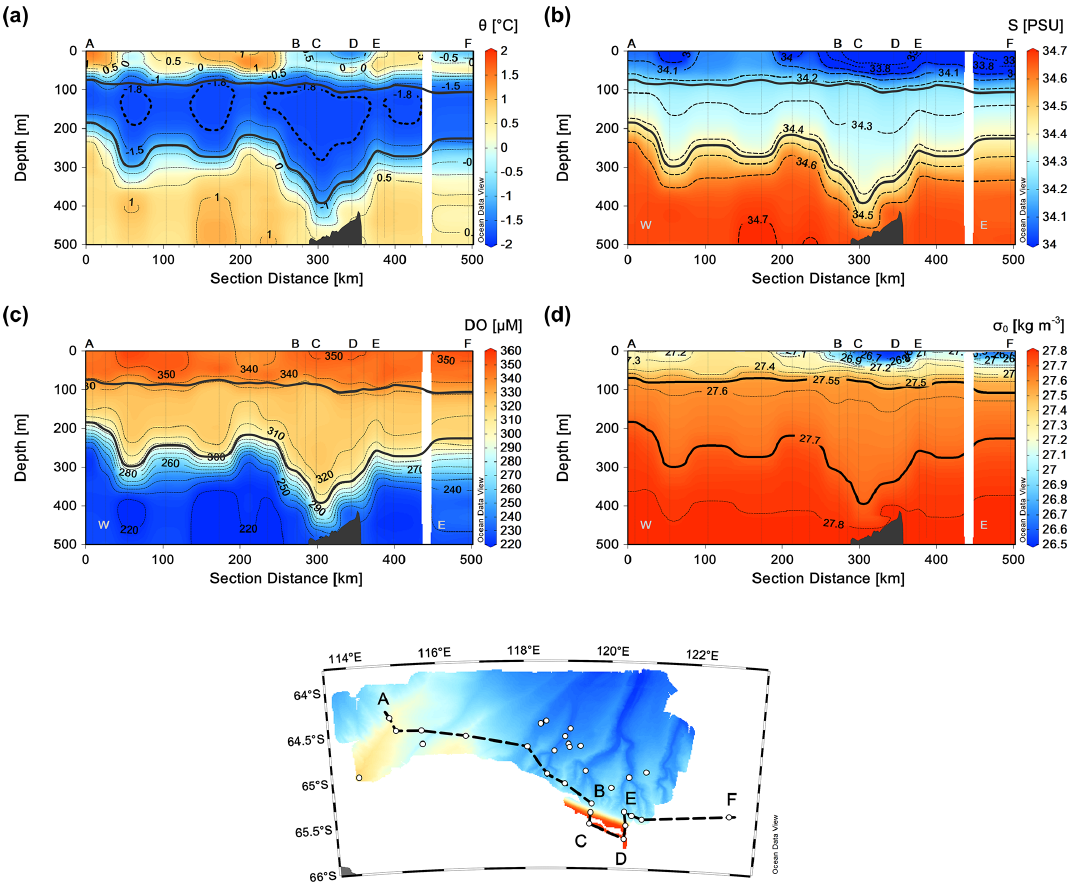
Figure 5. Along-slope transect (A–B, C–D, E–F) against distance, with two across-slope segments B–C and D–E. Vertical sections of θ (a) , S (b) , DO concentration (c) , and σ θ referring to 0dbar (d) in the upper 500m. Thick black lines in each panel indicate isopycnals 27.55 and 27.70kgm − 3 , delimiting the layer occupied by WW (defined according to Silvano et al., 2017). See the insert map for the location of the